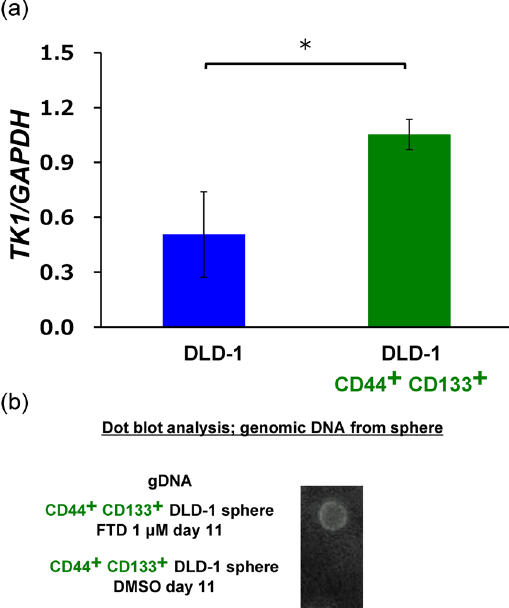
Figure 4. Thymidine kinase (TK1) expression and FTD incorporation in CD44 + CD133 + DLD-1 cells. ( a ) TK1 expression in CD44 + CD133 + cells. TK1 levels in DLD-1 cells and CD44 + CD133 + DLD-1 cells were assayed using qRT-PCR and normalized against GAPDH levels. Data points represent means ± SD of triplicate determinations; Student’s t -test, * P < 0.05. ( b ) Dot plot analysis of FTD incorporation into the genomic DNA of CD44 + CD133 + DLD - 1 spheres. CD44 + CD133 + DLD-1 cells were cultured in the presence of 1 μ M FTD or DMSO for 11 days in sphere-formation assay conditions and genomic DNA was purified. Purified DNA (1 ng) was denatured with an alkaline solution (0.1 N NaOH), spotted onto a Hybond-N + membrane, and blotted with anti-BrdU